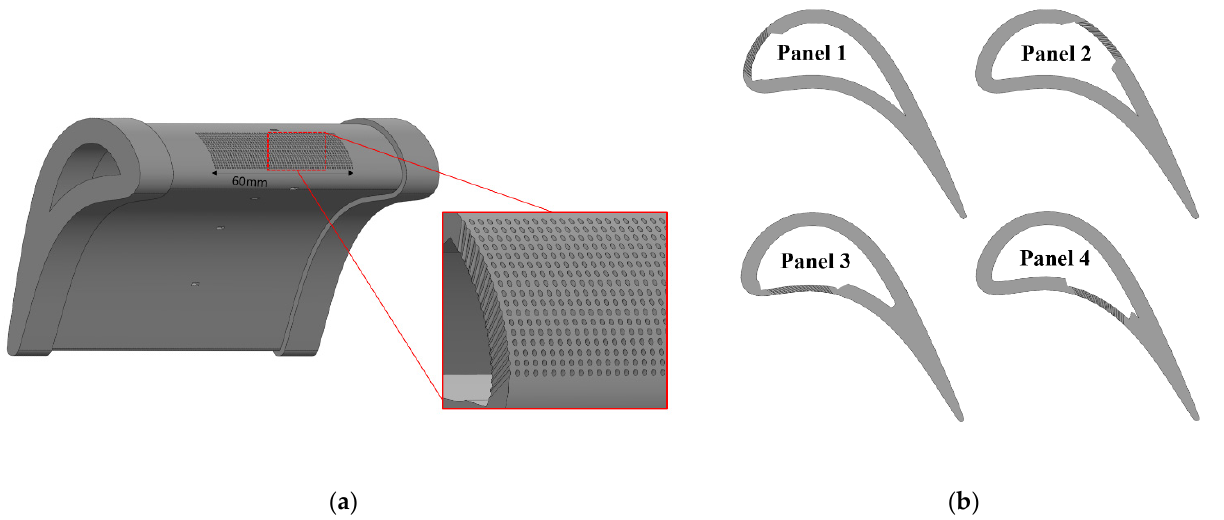
Figure 1. ( a ) Detail of Panel 1 geometry with ( b ) cross section indicating locations of Panels 1–4. Table 1. Summary of geometries tested.